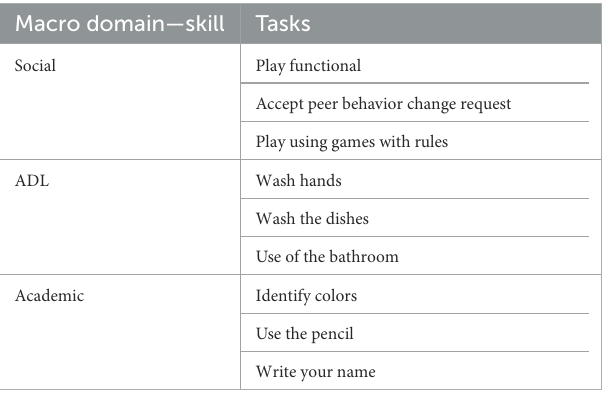
TABLE 1 Structure of some domains available in the ABA +